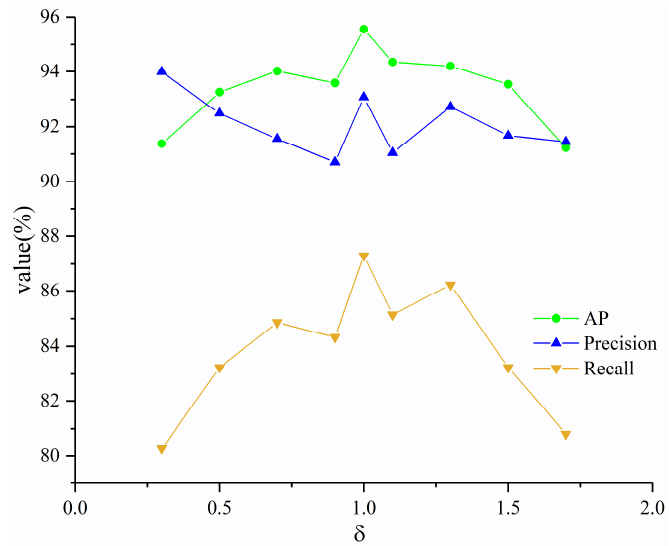
Figure 13. Performance analysis under different illuminations.